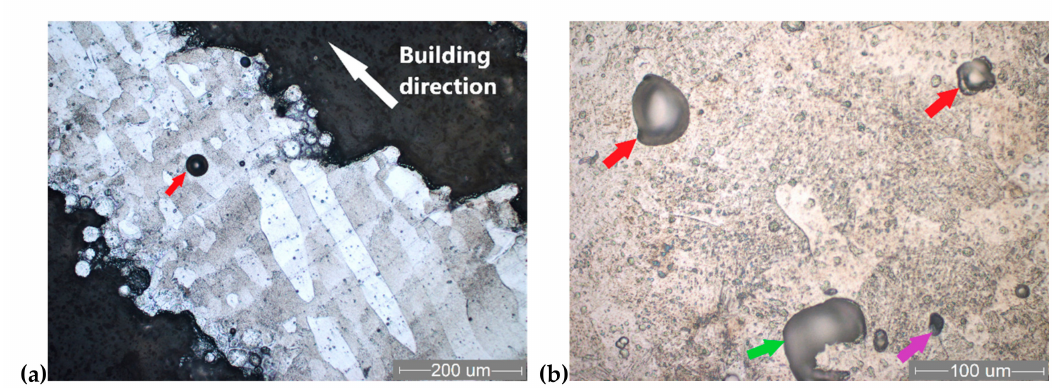
Figure 6. Optical micrographs of PHS specimens: ( a ) longitudinal section; ( b ) transverse section; and colored arrows indicate construction pores (Kroll’s